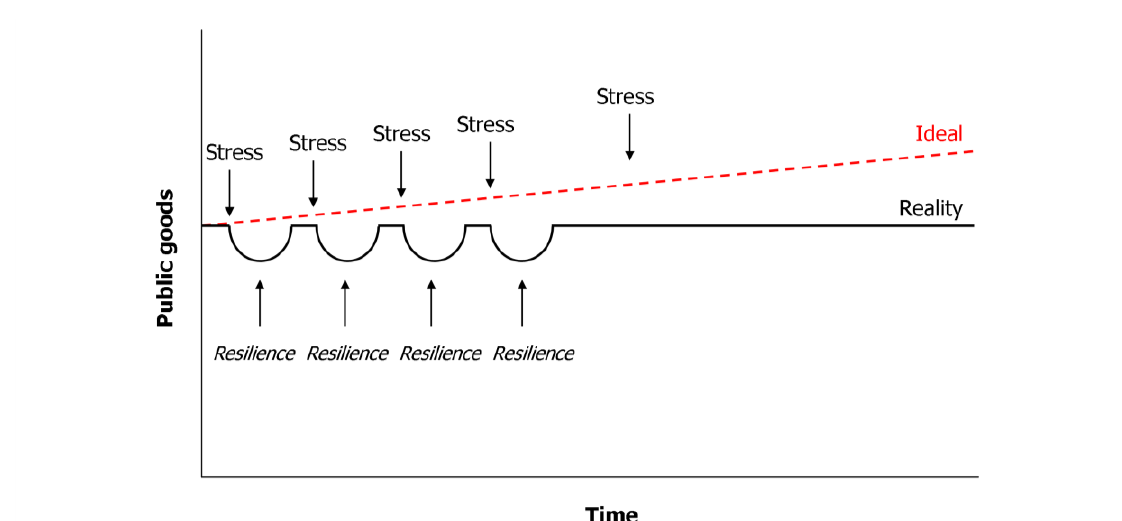
Figure 6. Expanded resilience model showing creeping erosion of public goods.